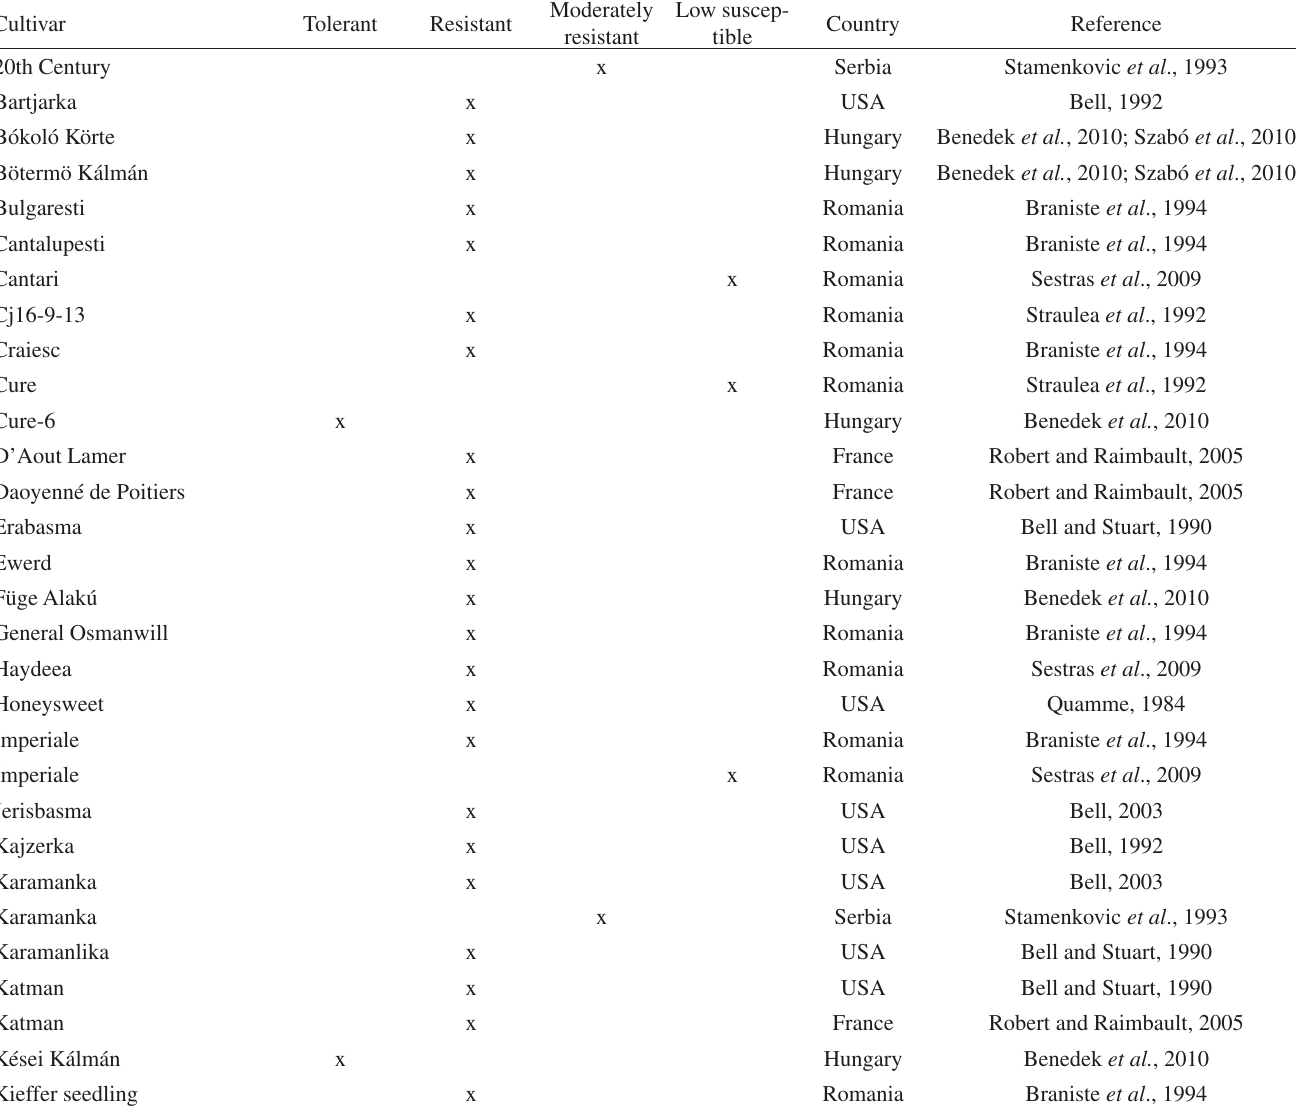
Table 2 - Pear cultivars showing some degree of resistance to psylla as reported by different authors Cultivar Tolerant Resistant